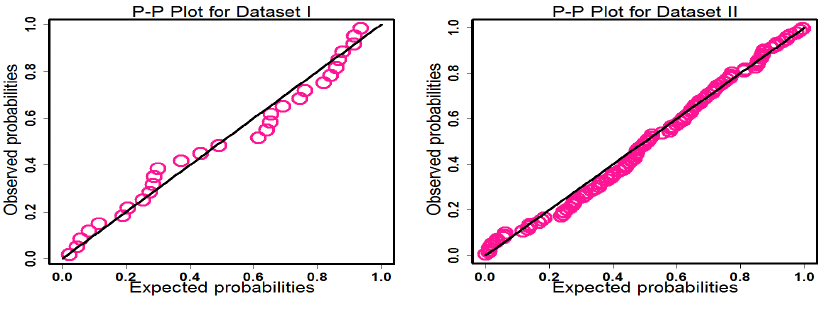
Fig. 14: P-P plot for Data Sets I and II.